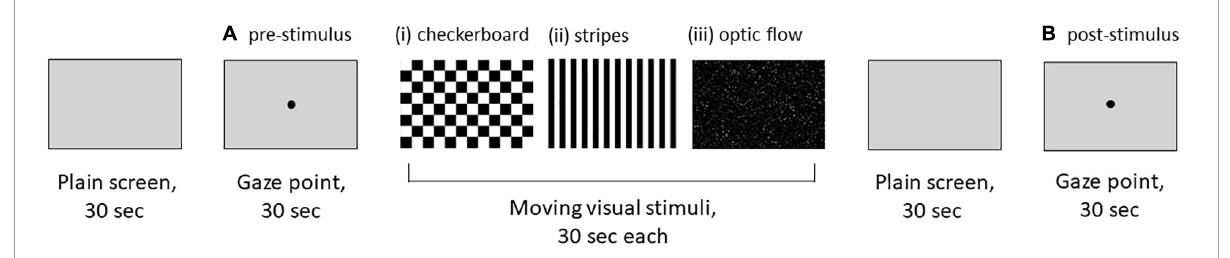
FIGURE1 An order of visual stimuli for the gaze stability test. (i) Checkerboard pattern stimulus comprising 8 rows × 12 columns of squares reversed in contrast (100%) at 12 Hz. (ii) Optokinetic stimulus with 12 black-and-white vertical stripes sweeping across a screen at 6 s. (iii) Radial optic flow stimulus with moving white dots (size: 0.1 ∼ 1.1 degrees of visual angle, speed: 3 s with a flat speed gradient) on a black background expanding from the center of the screen. (A,B) A stationary gazing black dot (5 mm diameter fixation target subtending approximately 0.4 of visual angle) in the center of the light gray screen [RGB (211, 211,